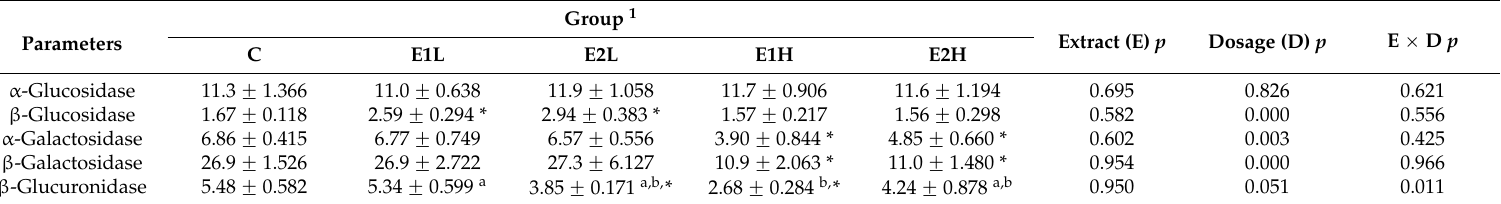
Table 2. Activity of microbial enzymes in the caecum digesta of rats ( µ